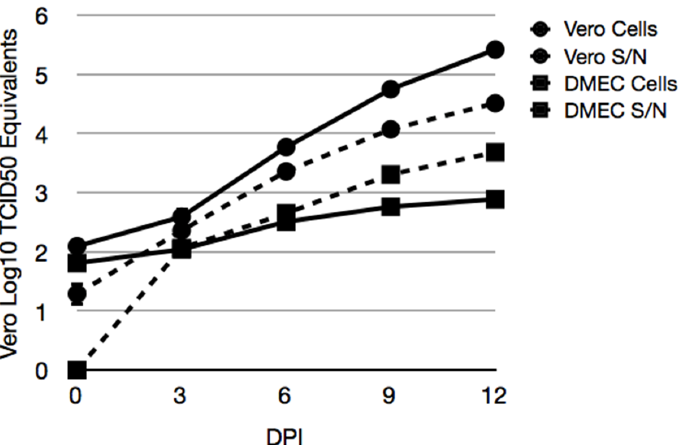
Figure 5. Accumulation of MAPV RNA in cellular fractions of infected deer mouse PMVEC. Vero E6 (circles) and deer mouse PMVEC (squares) were infected with MAPV to examine viral RNA in cells (hatched lines) and supernatants (solid lines) by real-time PCR. Cells were inoculated with 0.1 MOI of MAPV for 1 h, followed by removal of inoculum, 1× wash in PBS and addition of 2% FBS Ham’s F12 medium. The day 0 samples were collected 1 h later. The remaining samples were collected on days 3, 6, 9 and 12 dpi. RNA copies were determined relative to tissue culture infectious dose (TCID 50 ) equivalents.